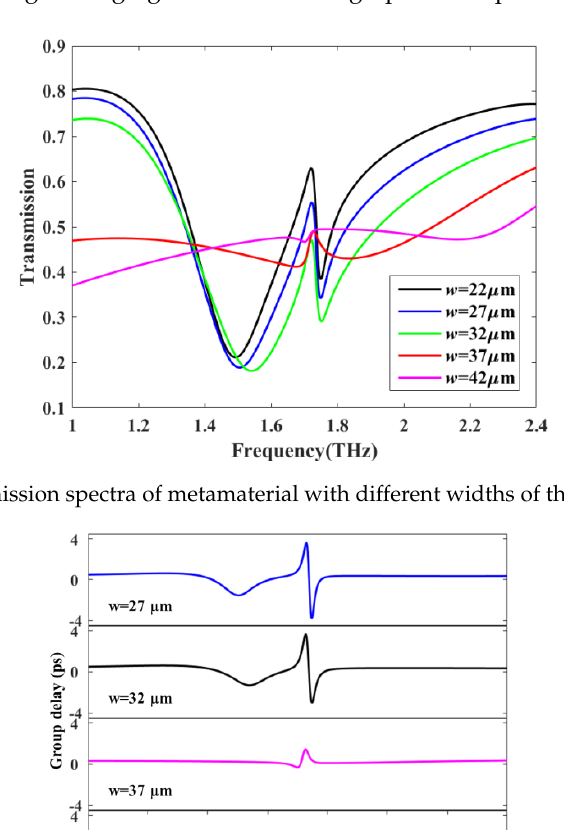
Figure 7. Transmission spectra of metamaterial with different widths of the graphene strip.